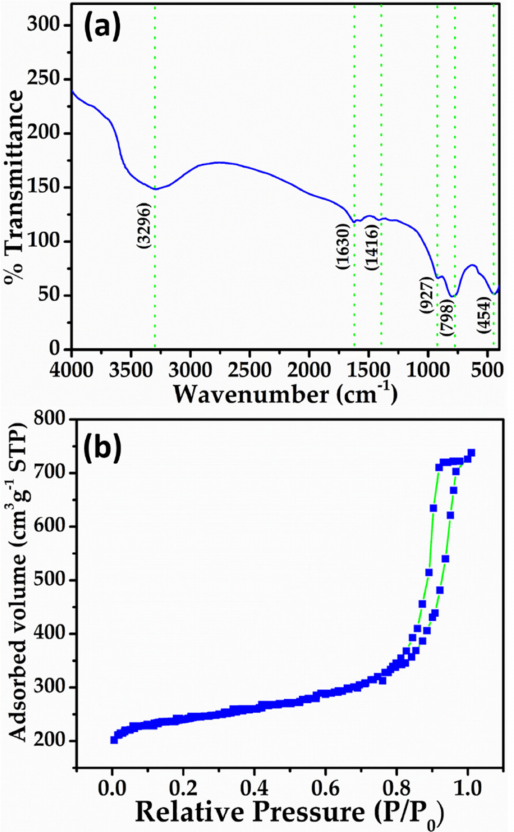
Figure 3. Typical ( a ) FTIR spectrum and ( b ) Adsorption-desorption isotherm of as-synthesized ZnO